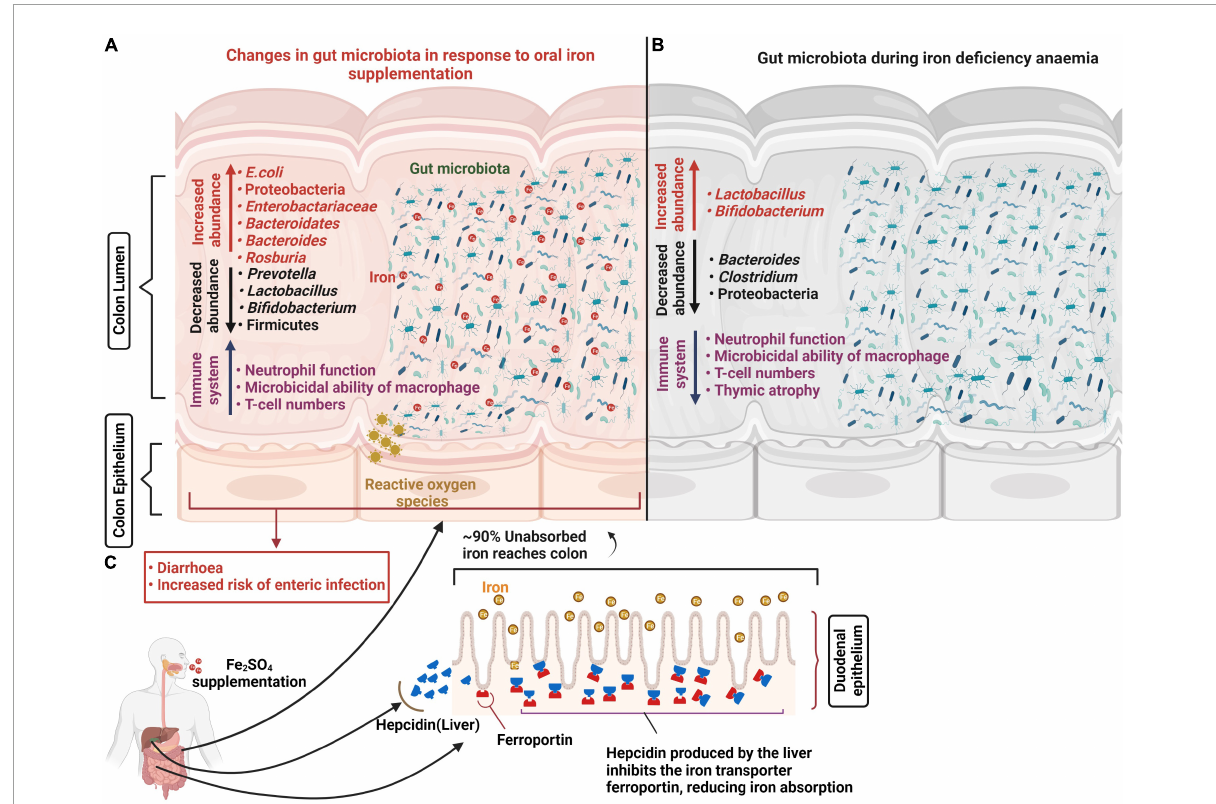
FIGURE1 Changes in the gut microbiota in response to oral iron supplementation and anemia. Iron supplementation prevents iron-deficiency anemia and aids the generation of appropriate immune responses to invading pathogens. However, approximately 90% of unabsorbed iron reaches the colon where most bacteria have substantial iron requirements for growth. This excess iron results in decreased abundance of beneficial bacteria including lactobacilli and bifidobacteria and increased abundance of potential pathogens including E. coli which increase the risk of diarrhea and enteric infection. In addition, oral iron supplementation may result in the generation of reactive oxygen species (ROS) causing oxidative stress and epithelial damage (A) . Abundance of potential pathogens including Bacteroides and Clostridium decrease in response to